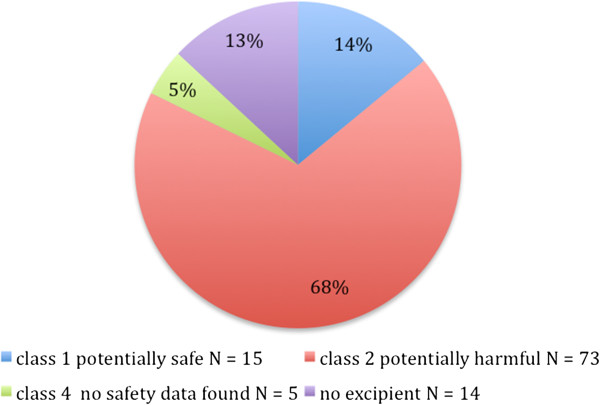
Proportion of prescribed medications, containing at least one excipient, in each safety category (every drug is listed once according to the worst-case scenario - into the most harmful category).